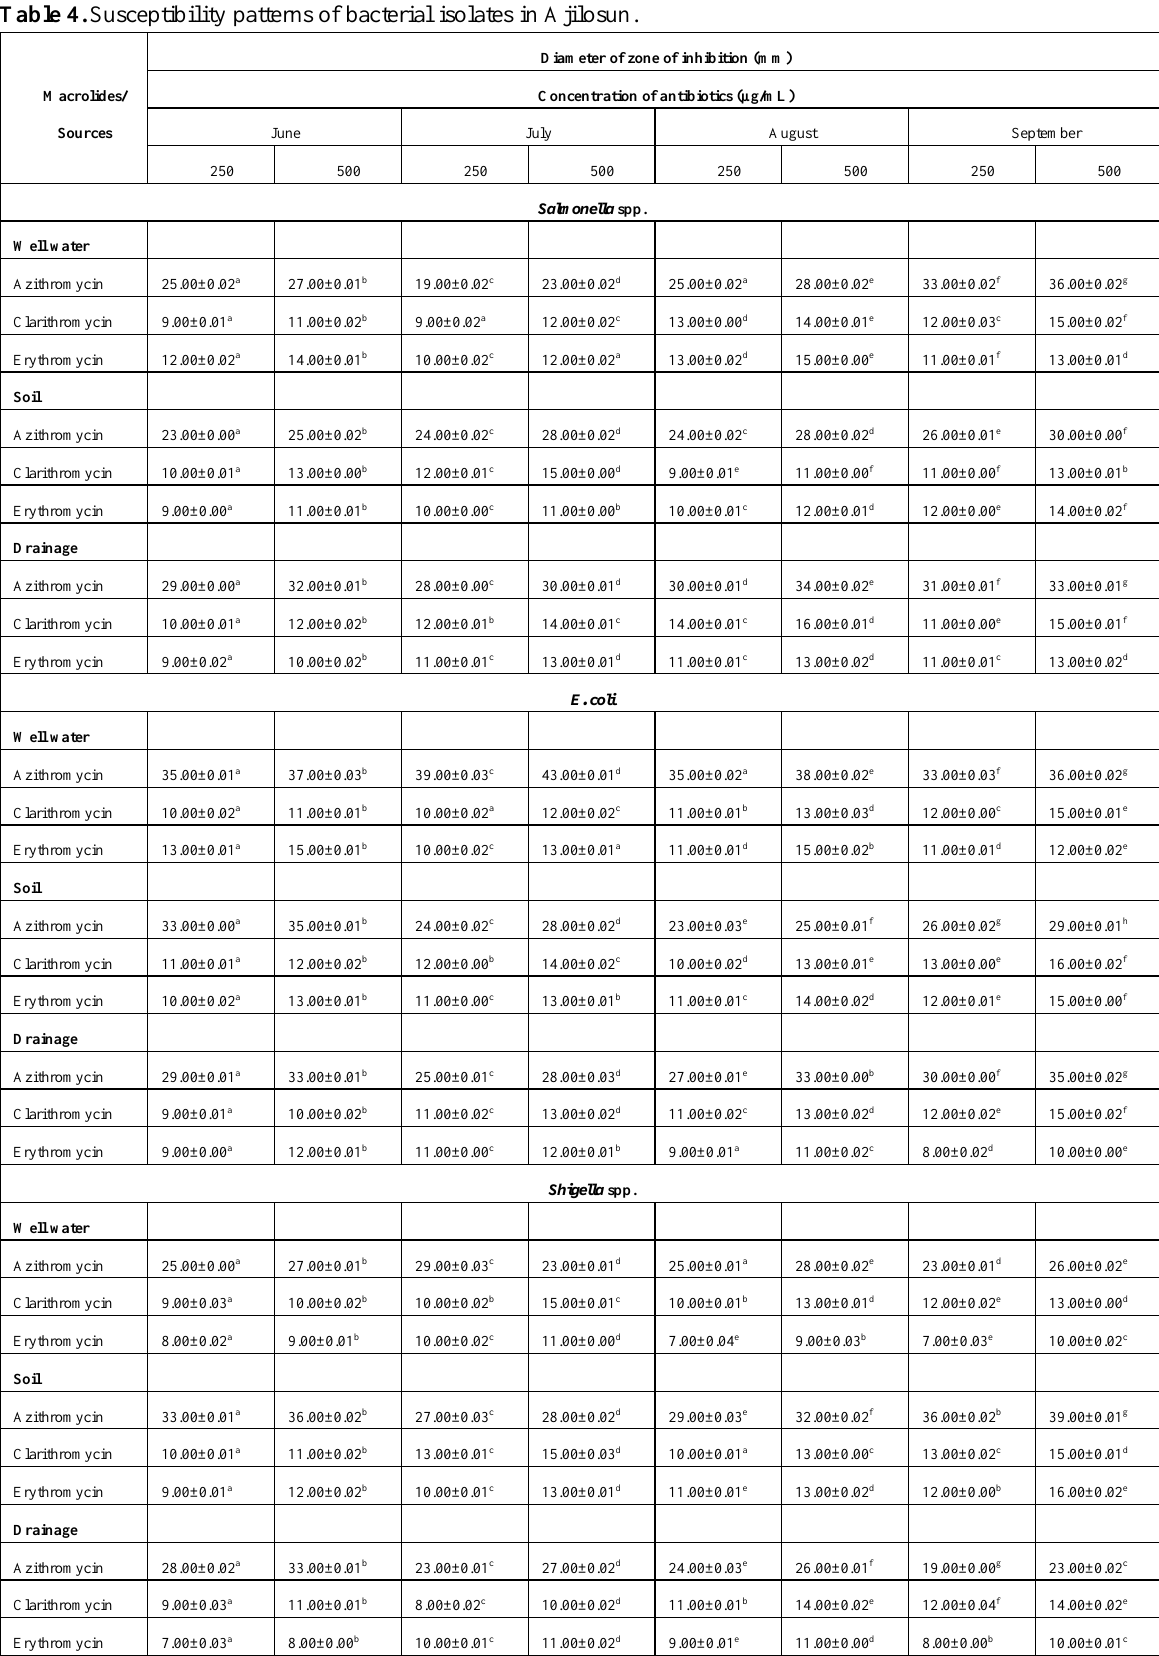
Table 4. Susceptibility patterns of bacterial isolates in Ajilosun.